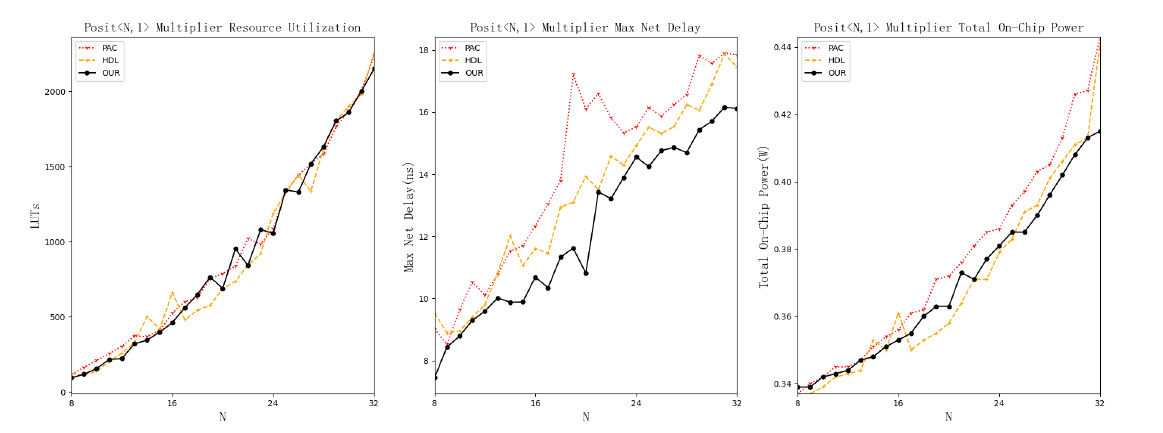
Figure 5. Posit<N,1> multiplier implementation results.